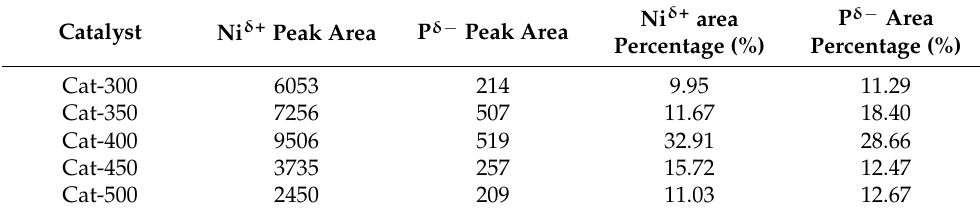
Table 1. Ni δ + and P δ − peak area of different Ni 2 P/Al 2 O 3 catalysts.